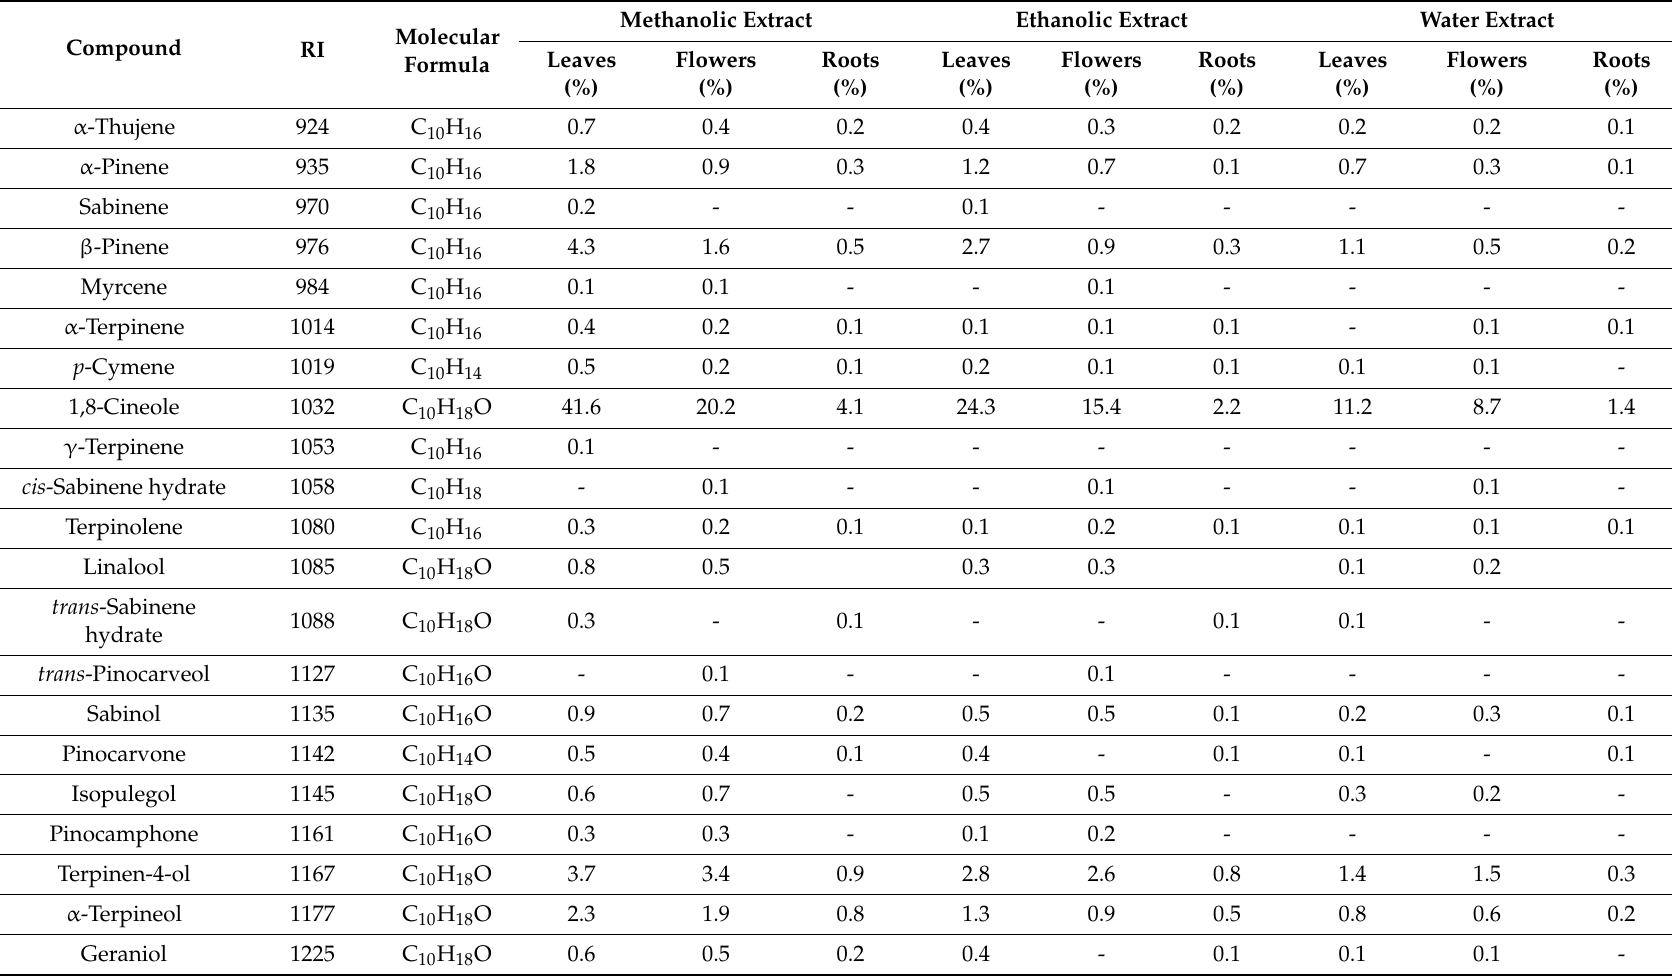
Table 2. Chemical composition of the Nepeta juncea